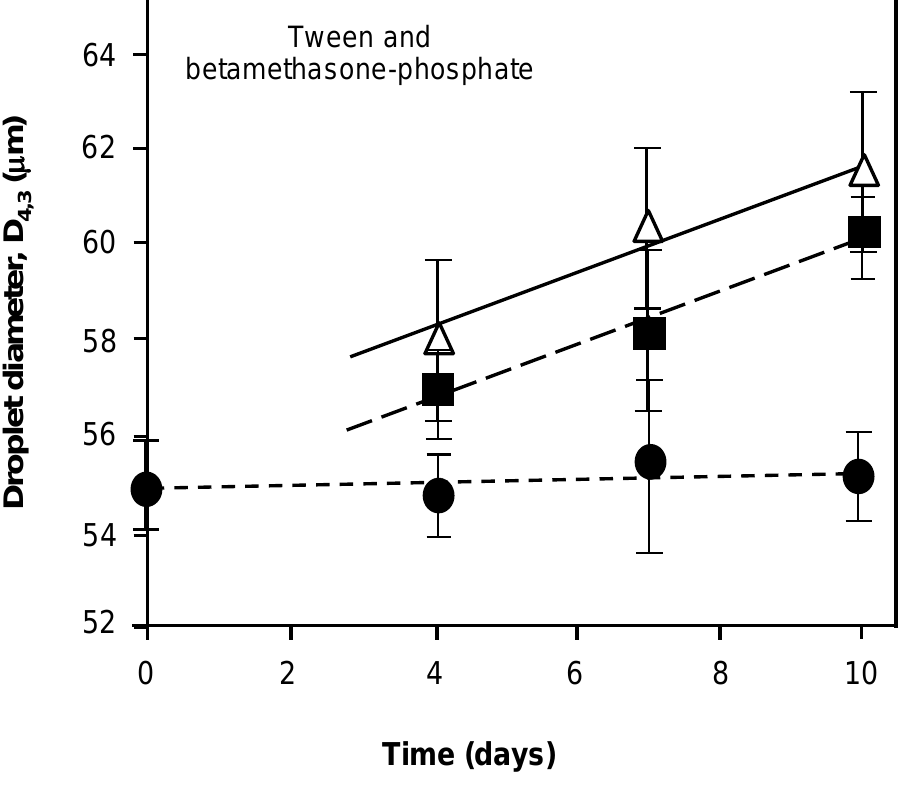
Figure 4. The droplet size of the base emulsion made from 1 mM Tween 80, 0.65 mM betamethasone 21-phosphate (BMP) and liquid paraffin as the dispersed phase in water in the presence of 1 × 10 − 5 M sodium azide (lines represent an aid to the eye to show the trend in the data) as a function of the storage time in days at a range of temperatures. The conditions of storage of the manufactured emulsion were 4 ◦ C ( • ), 25 ◦ C ( (cid:4) ) and 35 ◦ C ( (cid:52) ). All solutions used for samples were prepared from surface chemically pure 50 mM sodium phosphate buffered water, pH